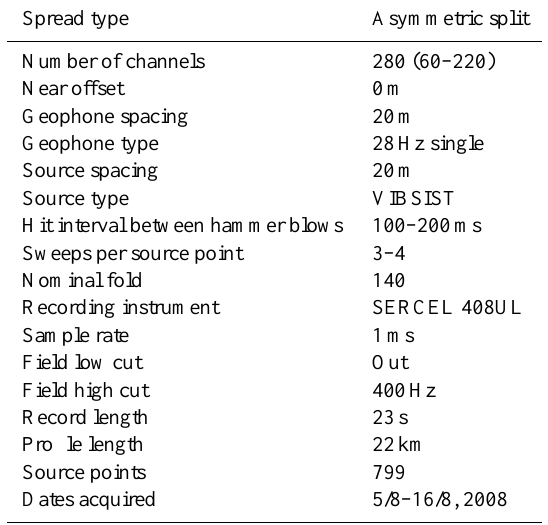
Table 1. Acquisition parameters for the reflection seismic experi- ment.